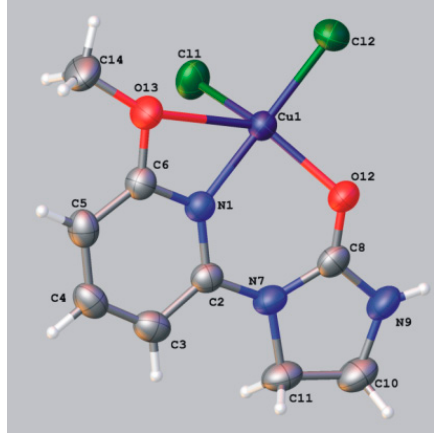
Figure 3. ORTEP representation of molecular structure of 6a .